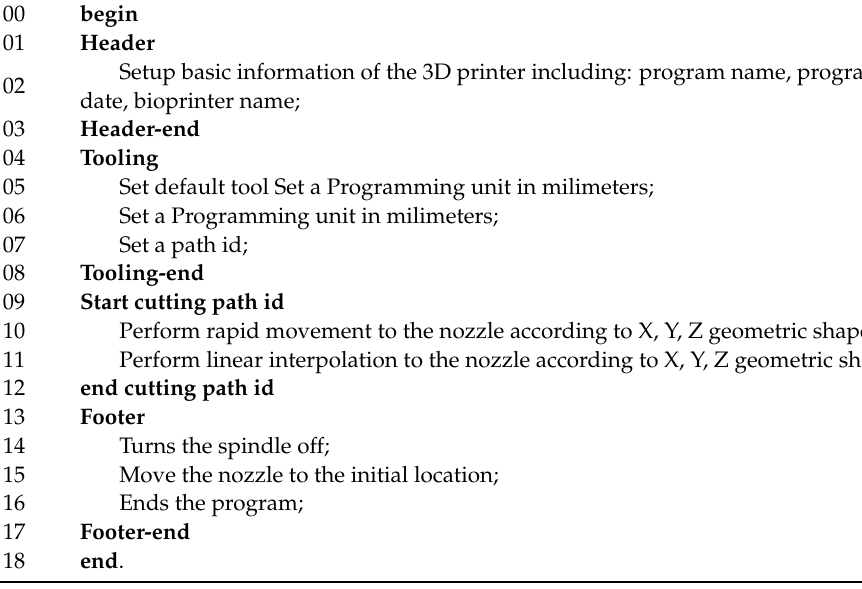
Algorithm A1: The designed algorithm for the 3D printed